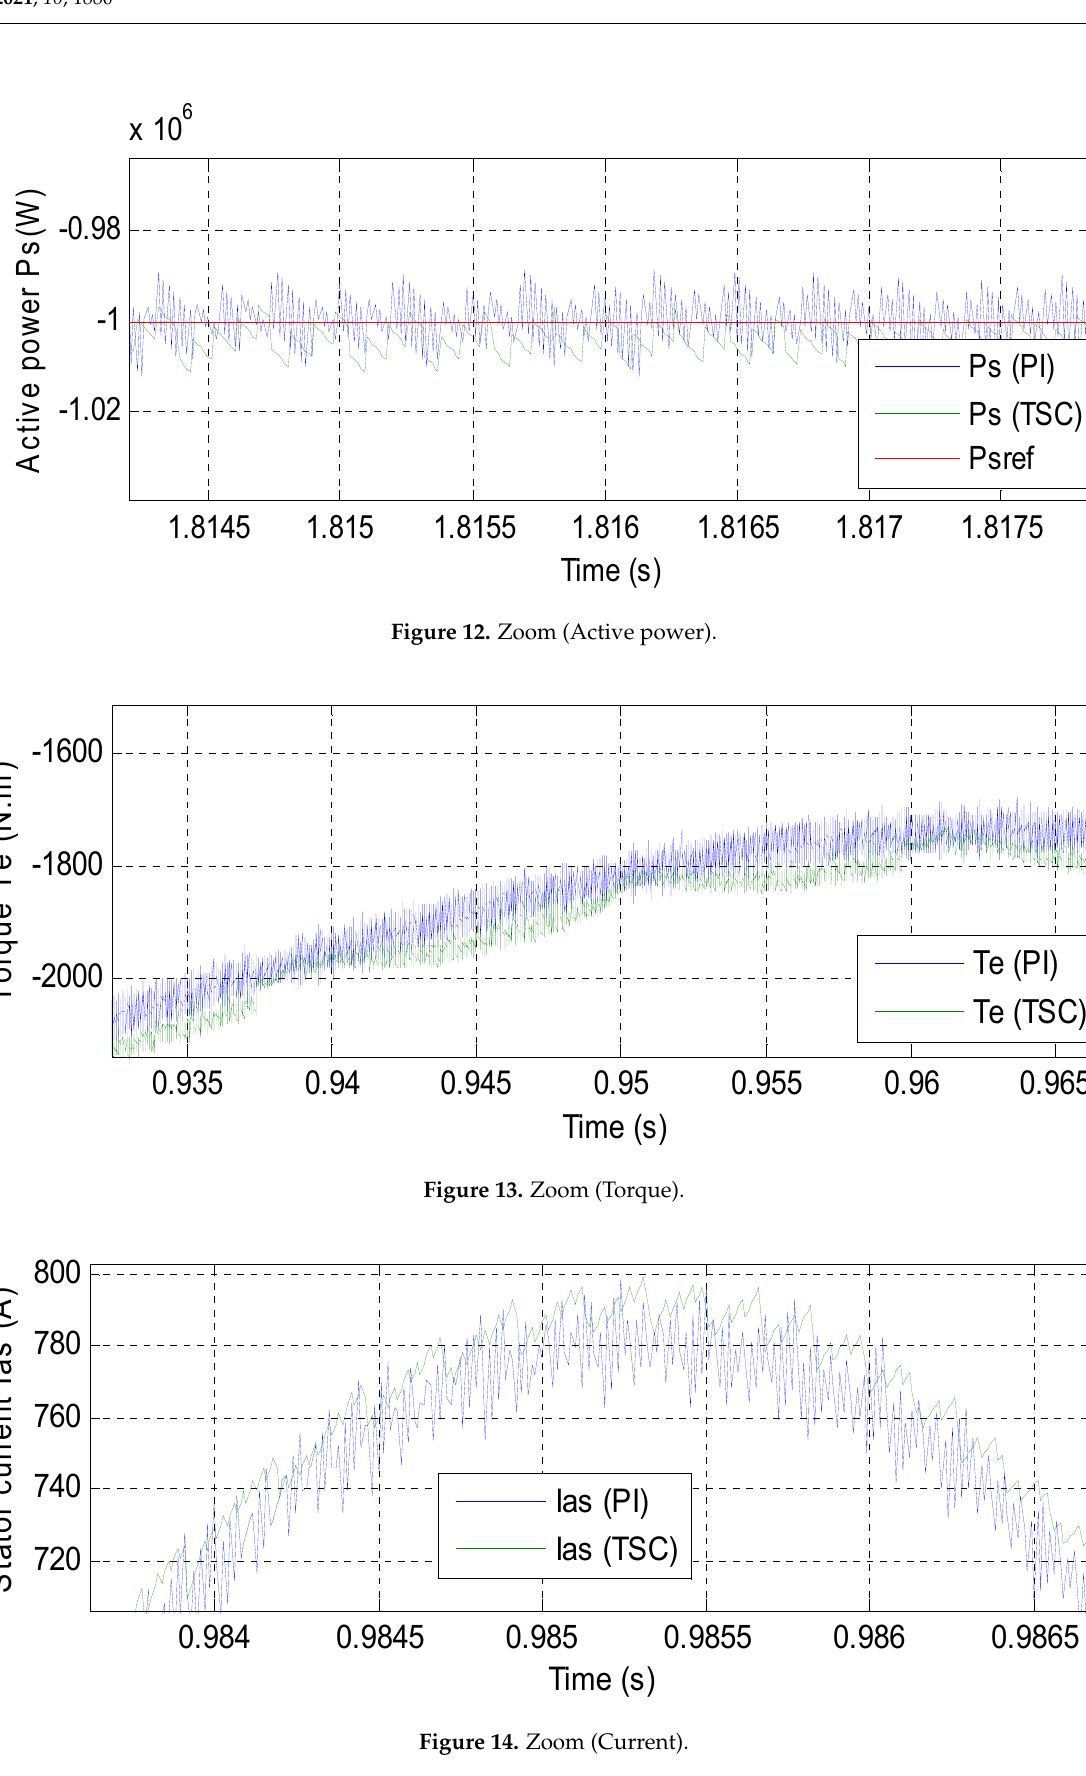
Figure 14. Zoom (Current).